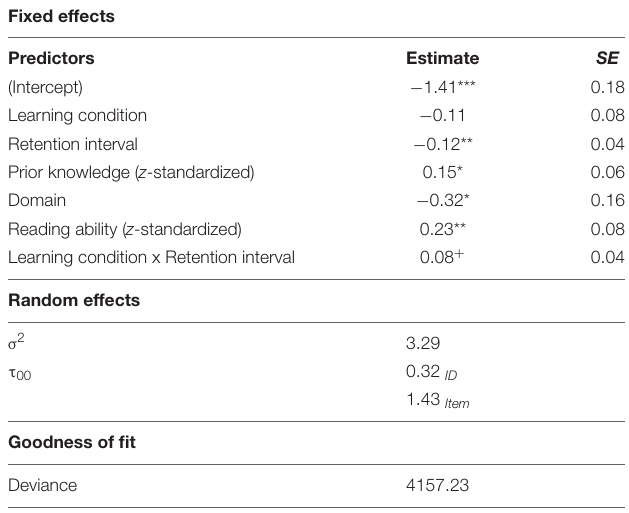
TABLE 2 | Parameter estimates and significance tests for the generalized mixed model for learning outcomes in experiment